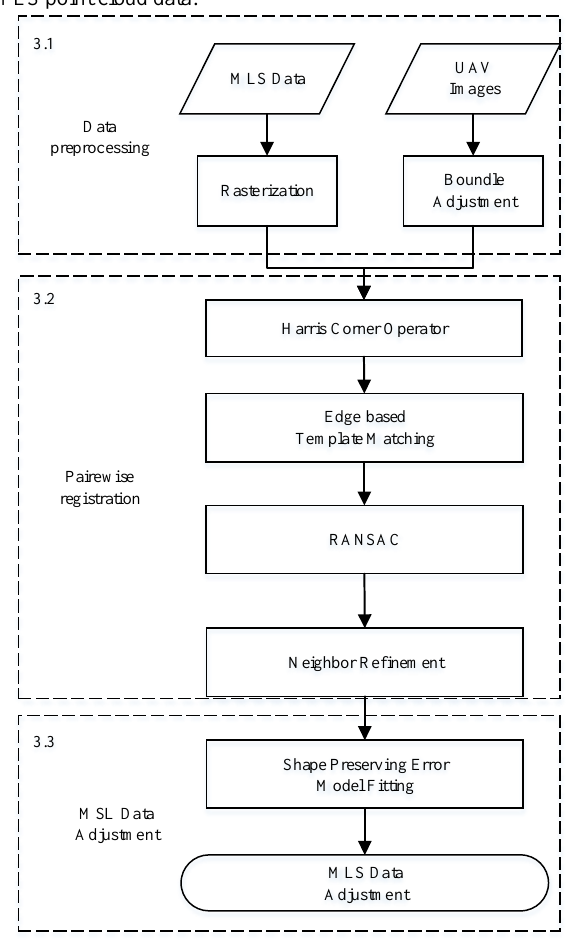
Figure 1. Processing-pipeline. Three phases: the data pre- processing of images and point clouds data, the main procedure of pairwise registration, and adjustment of the point clouds data.